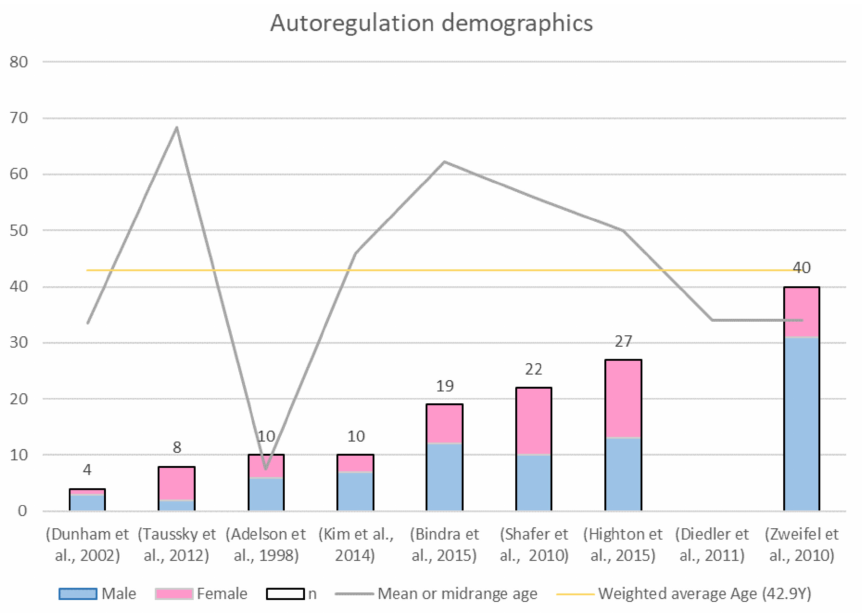
Figure 12. Demographics of the evidence on NIRS-derived autoregulation in